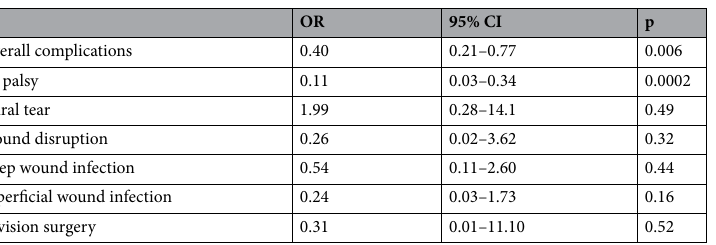
Table 3. Logistic regression analysis for complications and revision surgery in the weighted sample of patients undergoing laminoplasty or posterior spinal fusion. Weighted for IPTW and further adjusted for baseline age, sex, VAS (pain or numbness in the arms or hands), preoperative JOACMEQ (bladder function), preoperative comorbidity (cerebrovascular disease). IPTW inverse probability of treated weighting, JOACMEQ the Japanese Orthopaedic Association Cervical Myelopathy Evaluation Questionnaire, OR odds ratio, CI confidence intervals, VAS visual analogue scale.